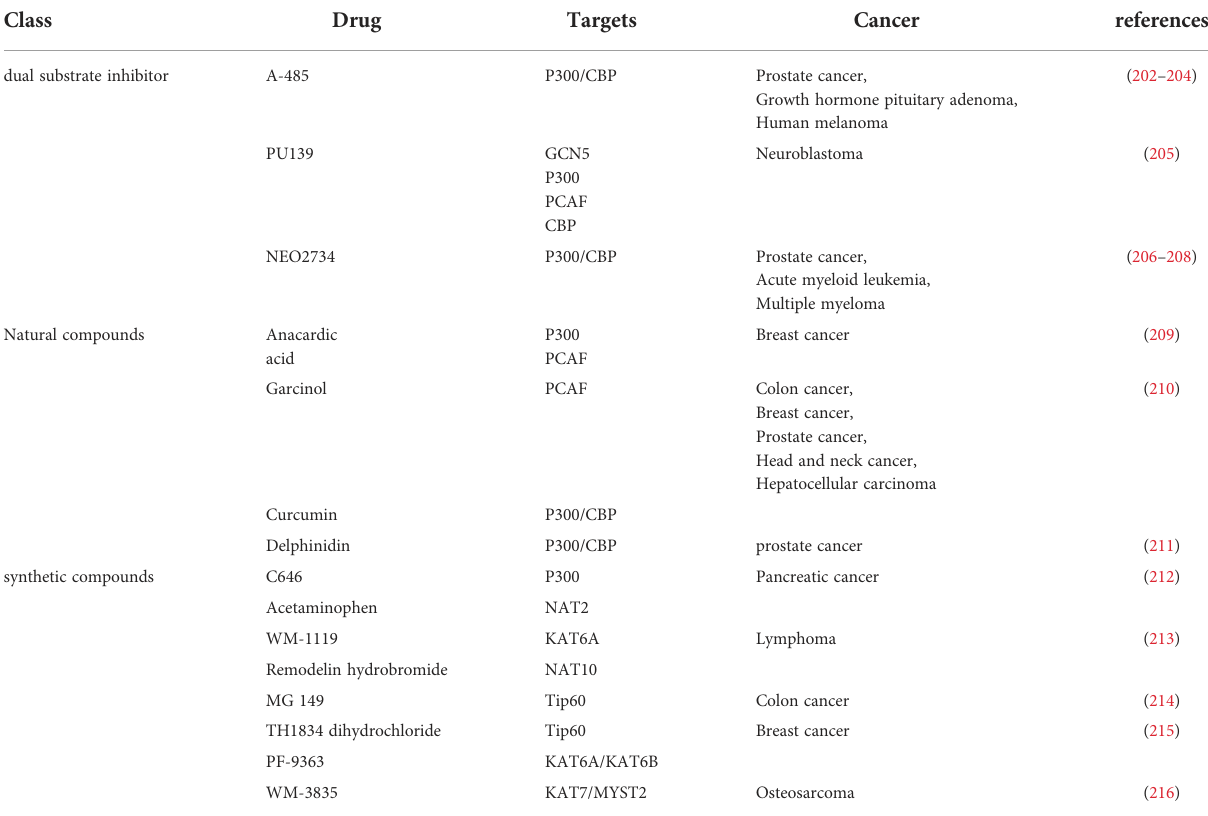
TABLE 3 Classi fi cation and targets of HAT inhibitors in